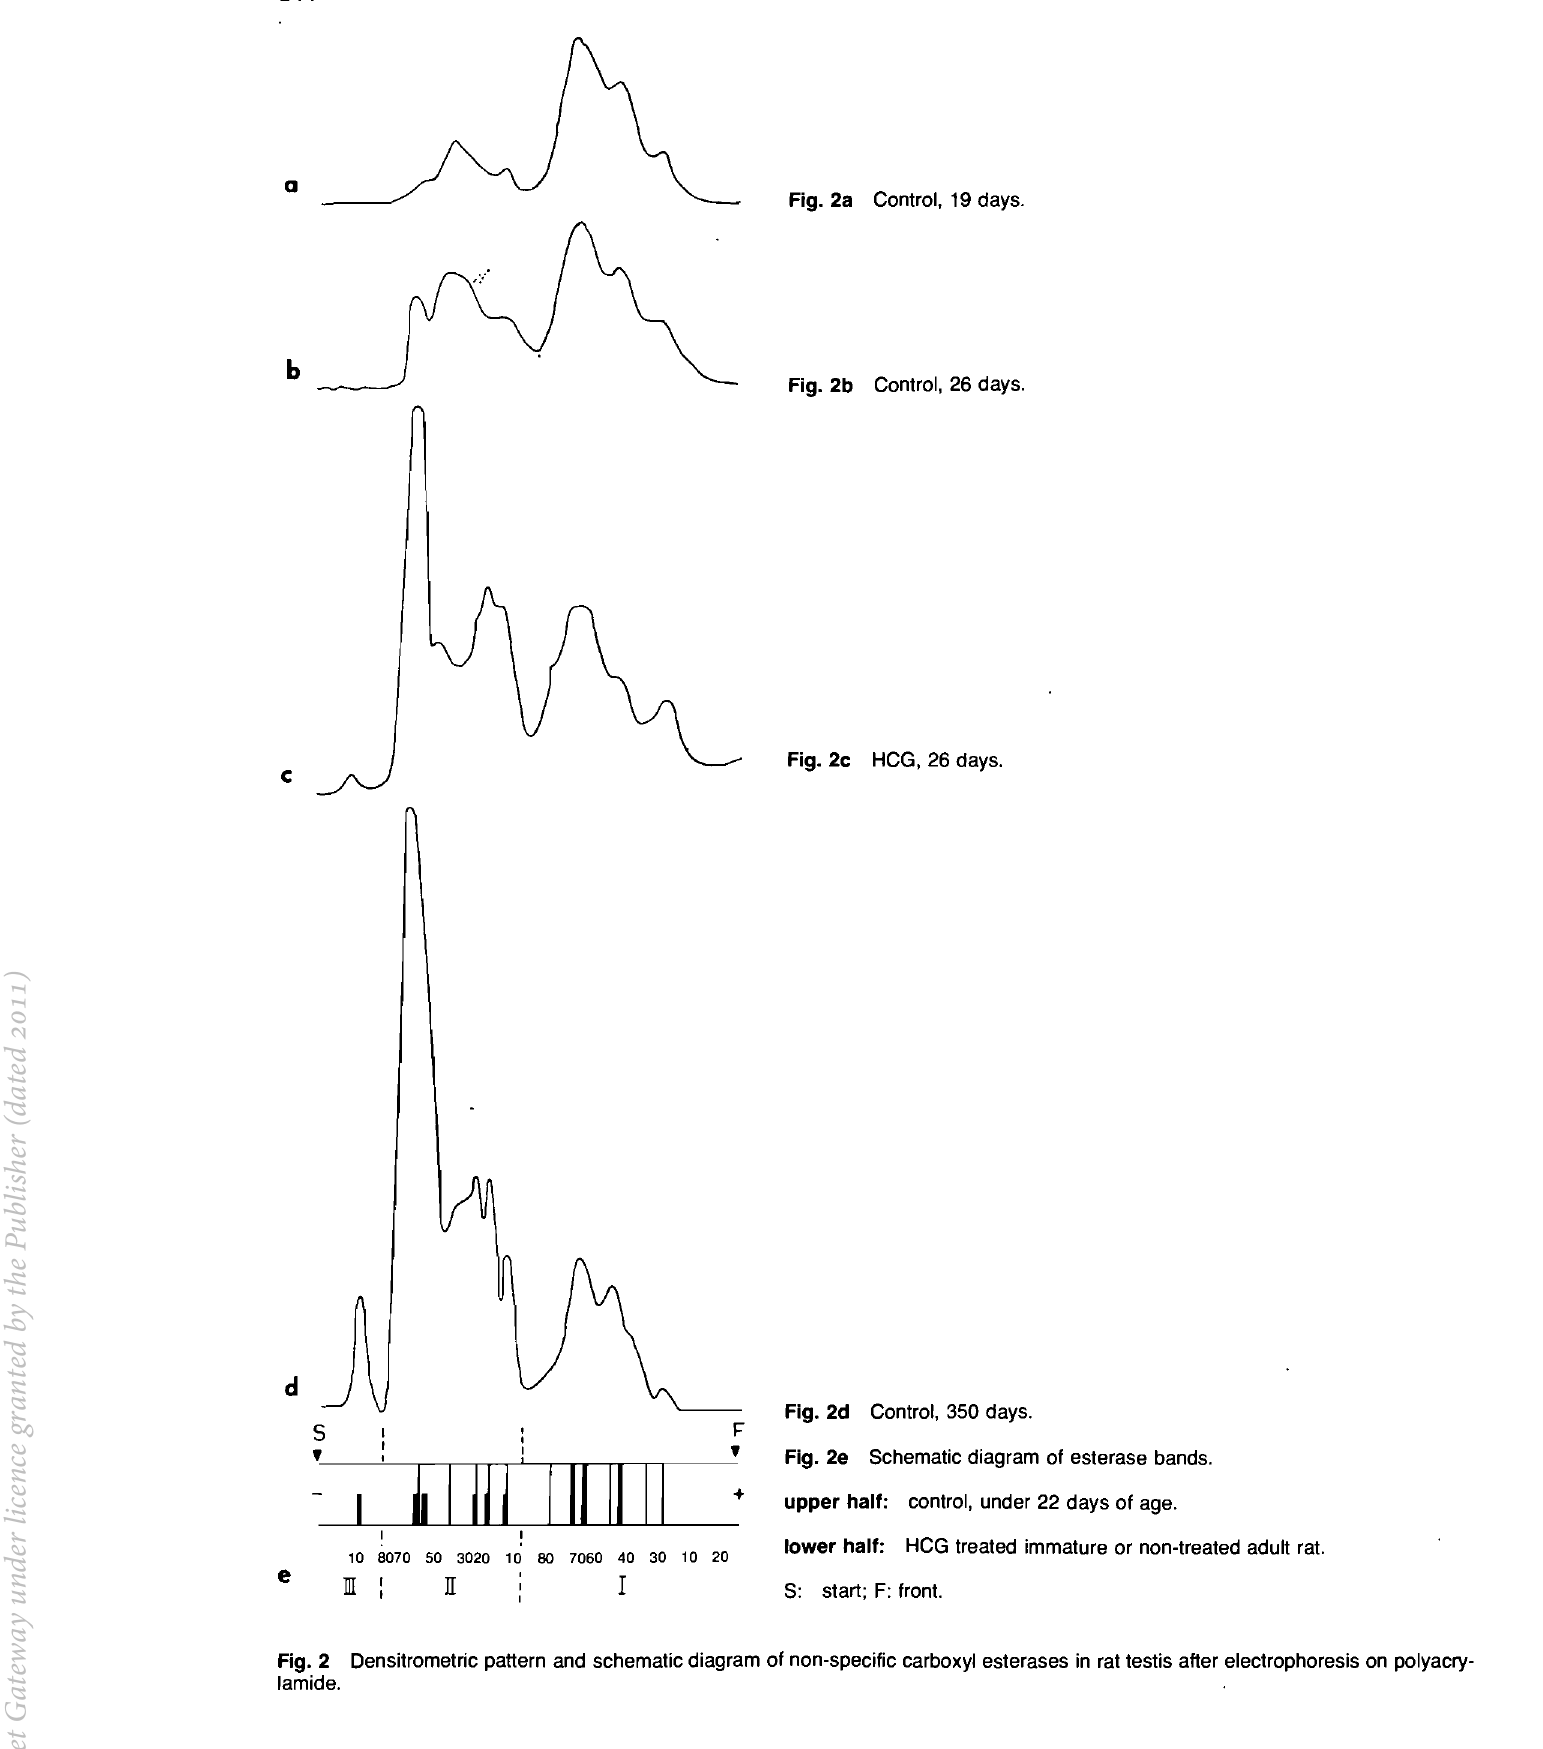
Fig. 2 Densitrometric pattern and schematic diagram of non·specific carboxyl esterases in rat testis after electrophoresis on polyacry·